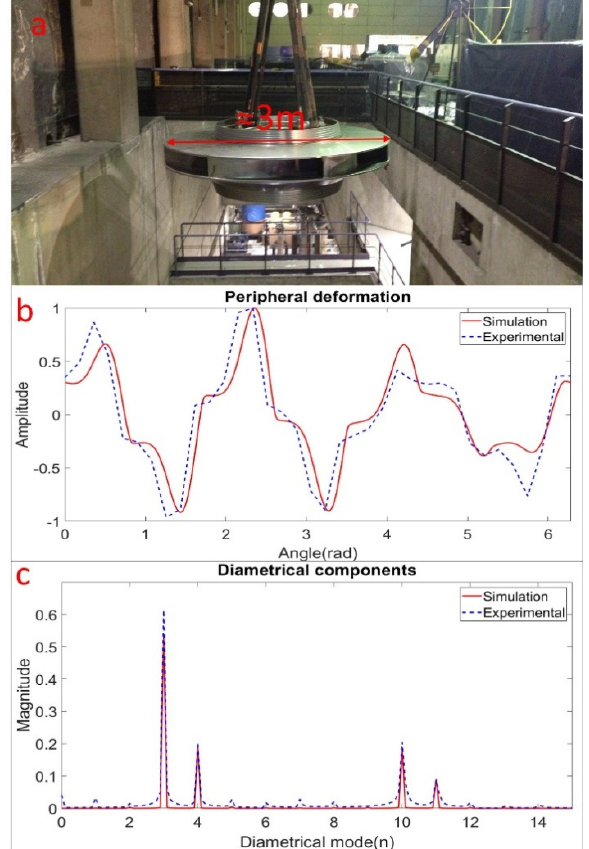
Figure 6. Diametrical mode of a real impeller (non-rotating structure): ( a ) Impeller analyzed, ( b ) Peripheral deformation of the diametrical mode with main component n = 3, ( c ) Amplitude of the components obtained with mode shape decomposition.